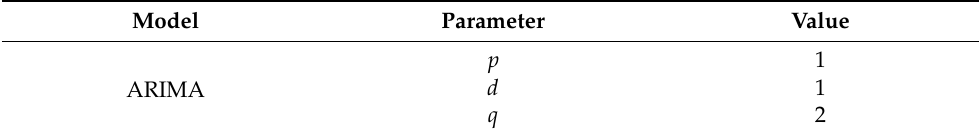
Table 2. Summary of model parameters for the ARIMA model.